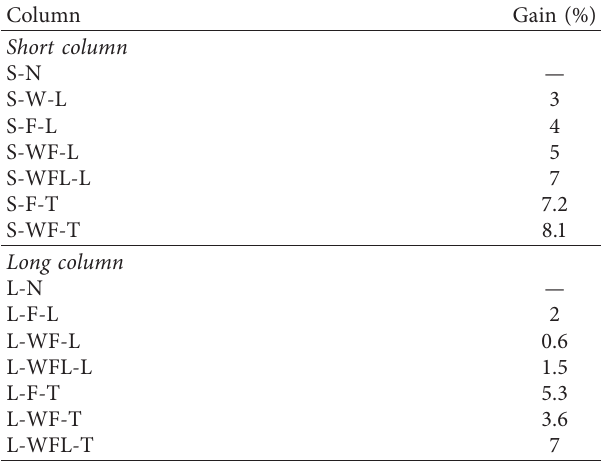
Figure 10: Numerical failure modes of the (a) S-F-0 and (b) L-F-0 columns. Table 5: Component growth